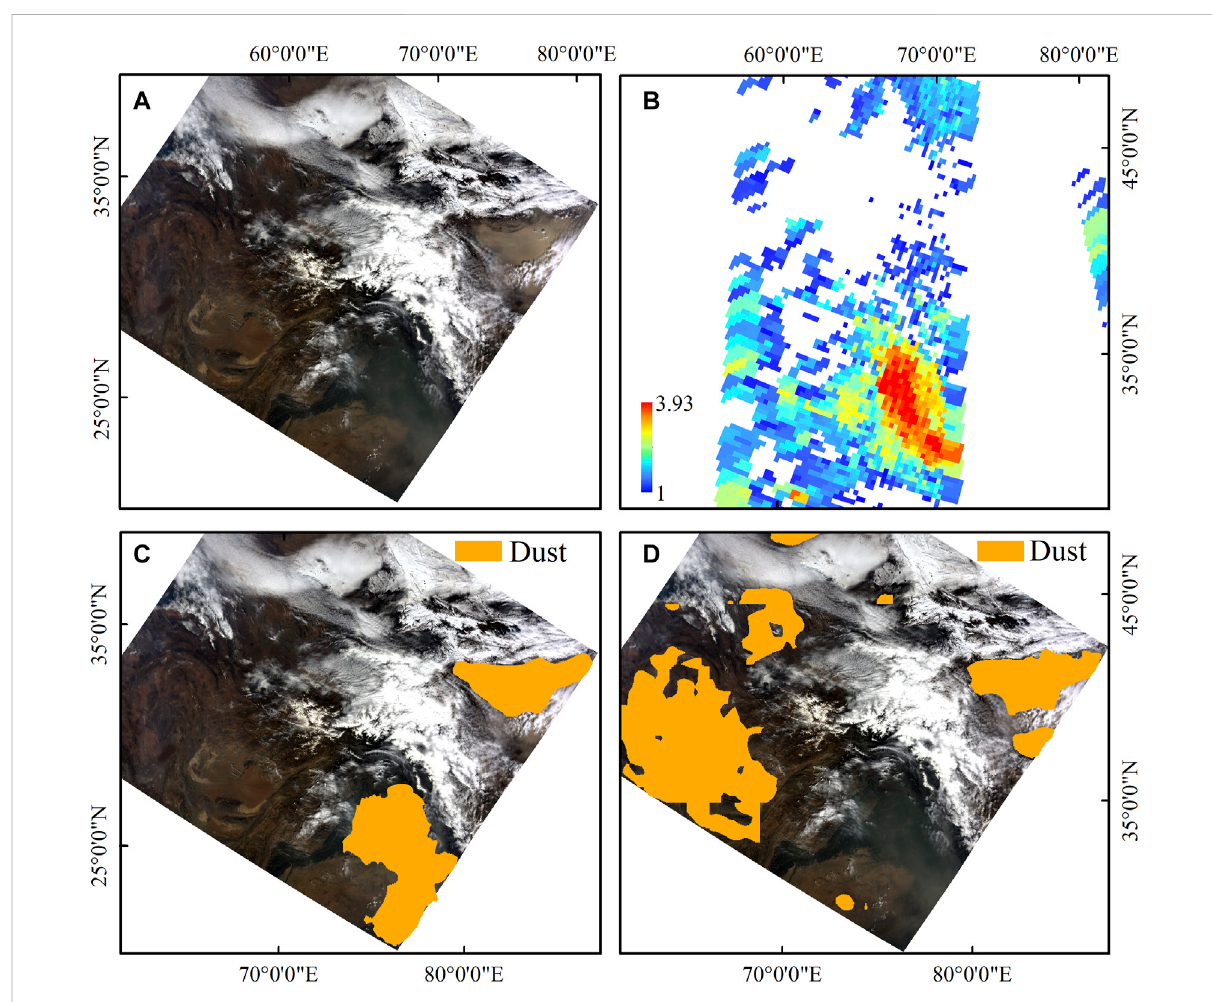
FIGURE 10 Comparison of sandstorm detection results in cloud/ice and snow in the region on 16 March 2021. Spatial distributions of MODIS image (band: 1-4-3) (A) , OMI AI product (B) , detection results of space sandstorms with LSR (C) , and detection results of space sandstorms in MODIS images without LSR (D)